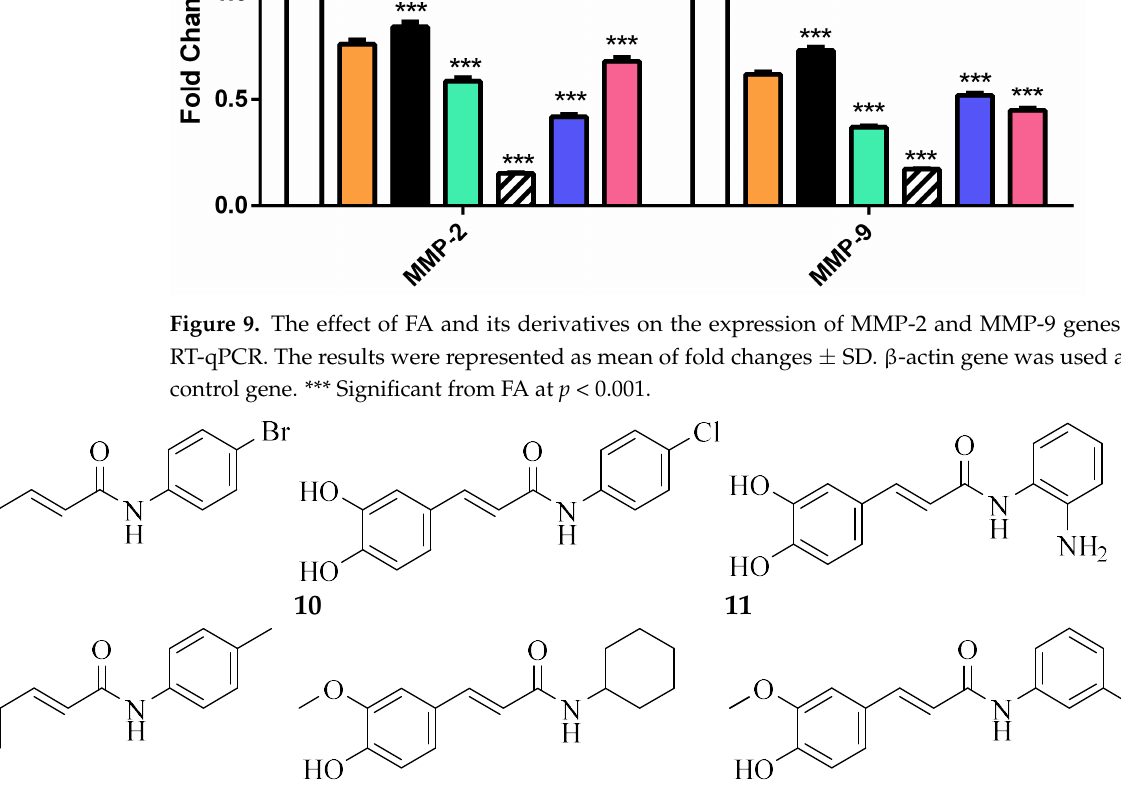
Figure 10. Structures of the most active compounds throughout all the biological tests.